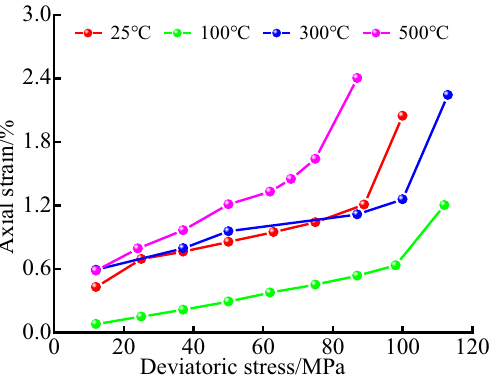
Figure7. Curve of axial strain change against deviatoric stress under different temperature conditions.